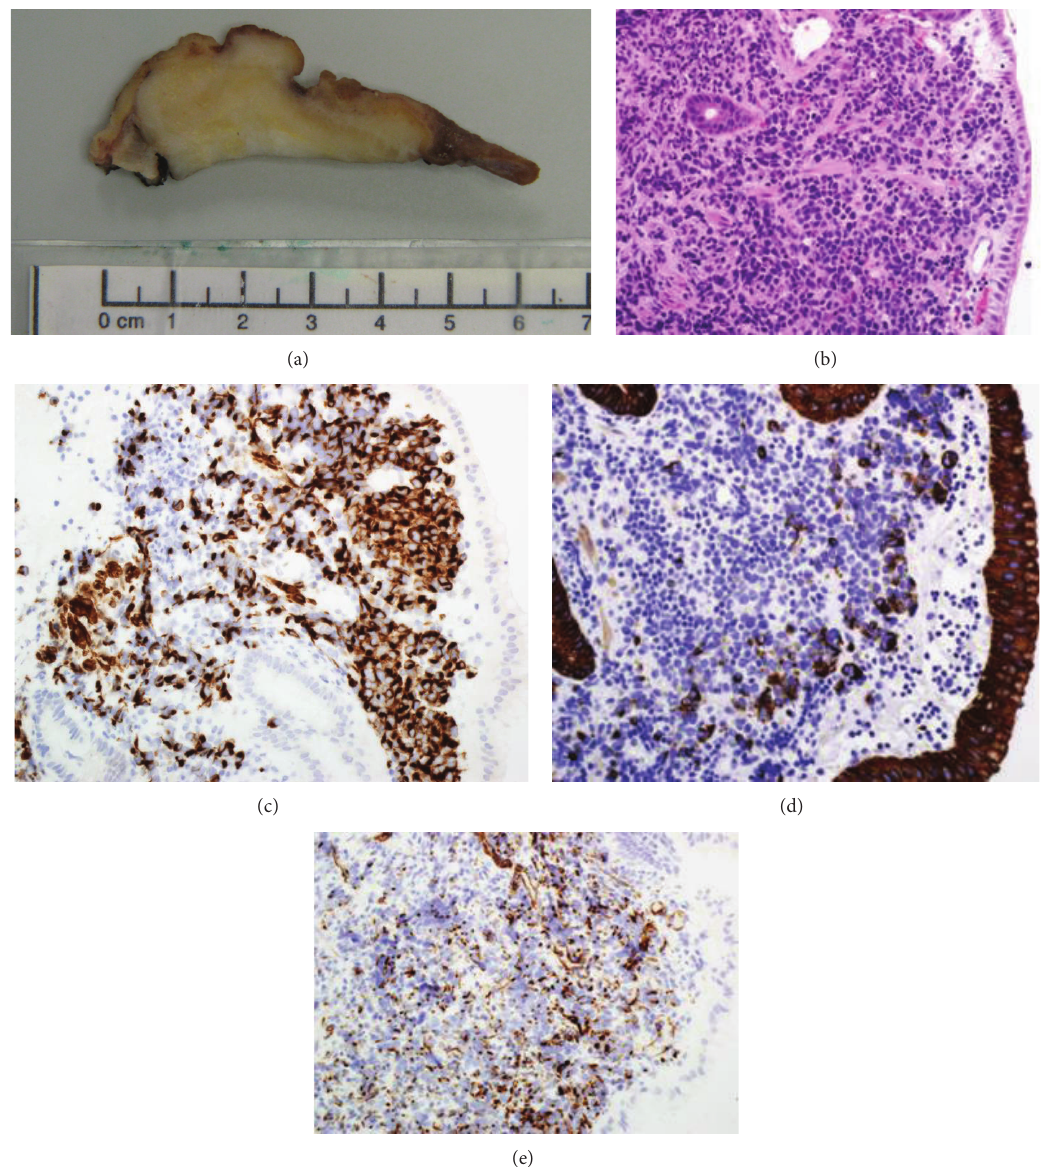
Figure 3: Desmoplastic small round cell tumor (DSRCT) of the resected gastric tumor mass. (a) Gross examination: cut section of gastric mass revealed a 2.5 × 4.5 × 6.5 cm, irregular, ulcerated, necrotic, and hemorrhagic mass involving the gastric fundus and extending into cardia and lower gastroesophageal junction. (b) Histopathological examination: showing intact epithelial mucosa and presence of sheets of small round blue cells separated by minimal desmoplastic fibrous stroma. (c) Desmin immunostaining: showing positive cytoplasmic staining in the tumor cells (magnification power: × 400). (d) AE1/AE3 (cytokeratin) immunostaining: showing focal mild positive staining in the tumor cells (magnification power: × 400). (e) WT1 immunostaining: showing dot-like positivity in the tumor cells (magnification power: ×